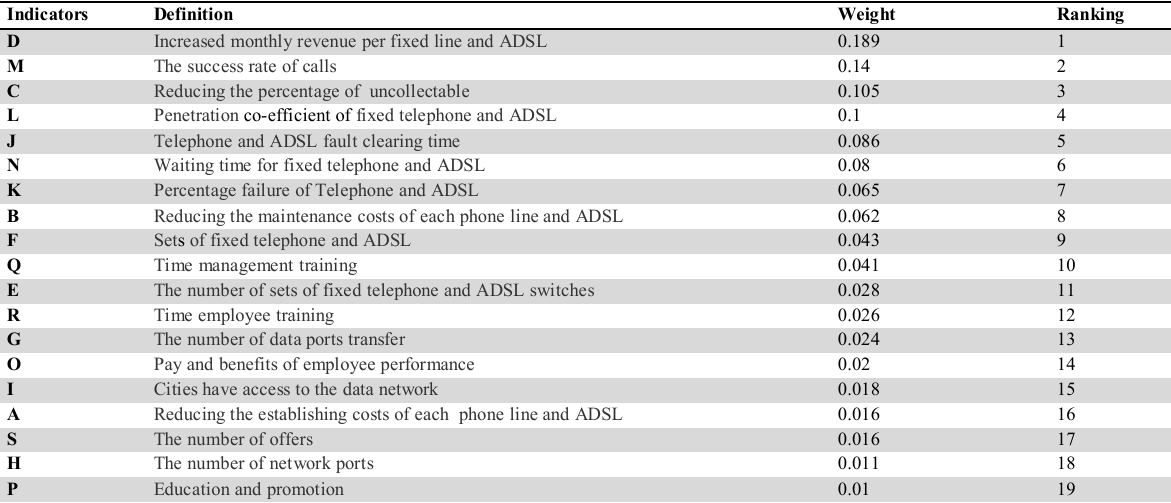
Weight and rank of